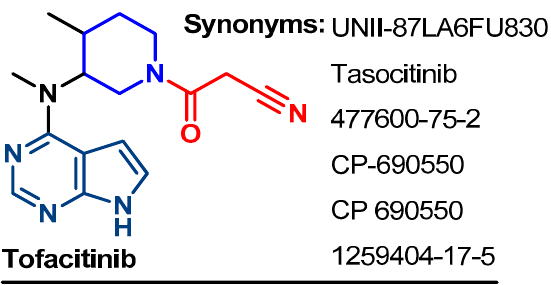
Figure 58. Chemical structure/name/synonyms of tofacitinib.